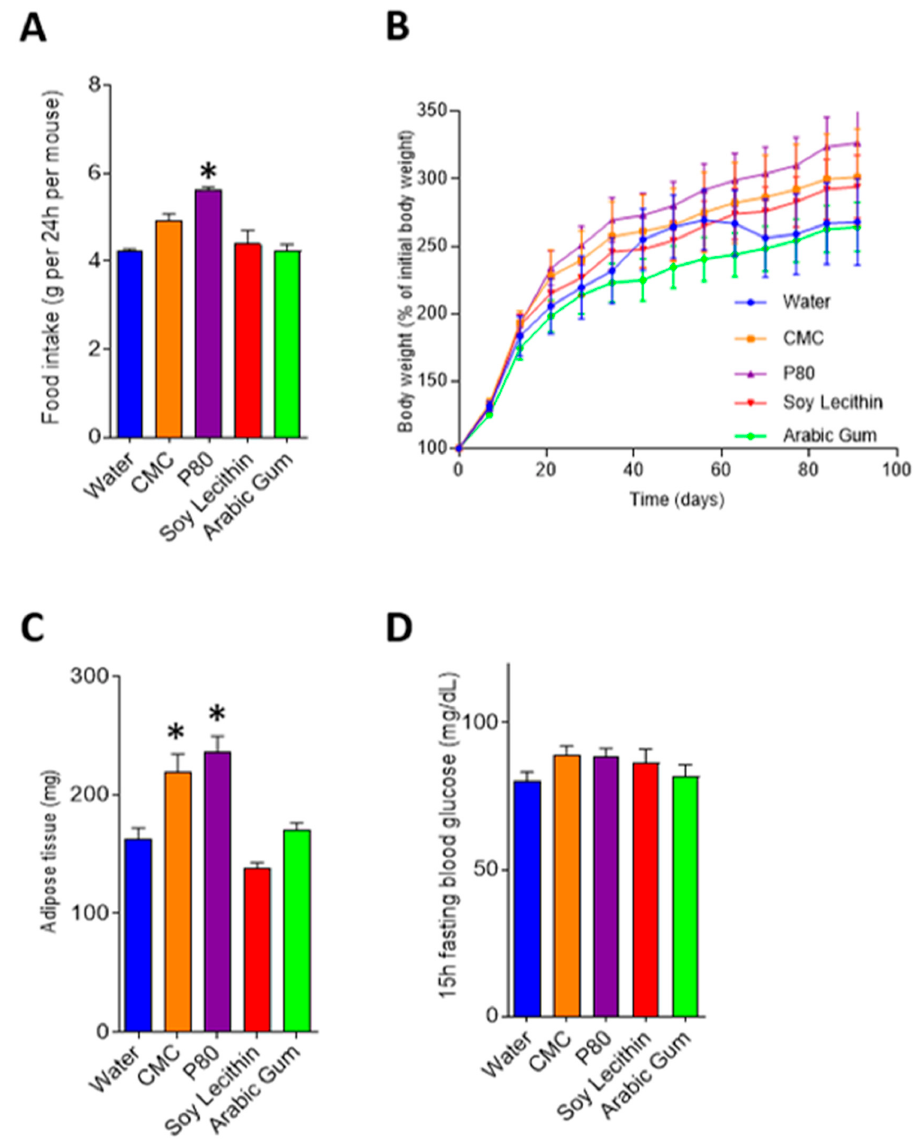
Figure 2. Food intake and metabolic markers in emulsifier and water-treated mice. Graphs depict mean and standard error for food intake ( A ), body weight ( B ), adipose tissue ( C ) and fasting blood glucose ( D ). * p < 0.05 compared with water (control) following ANOVA and Bonferroni post hoc correction. CMC, carboxymethylcellulose; P80, polysorbate-80.